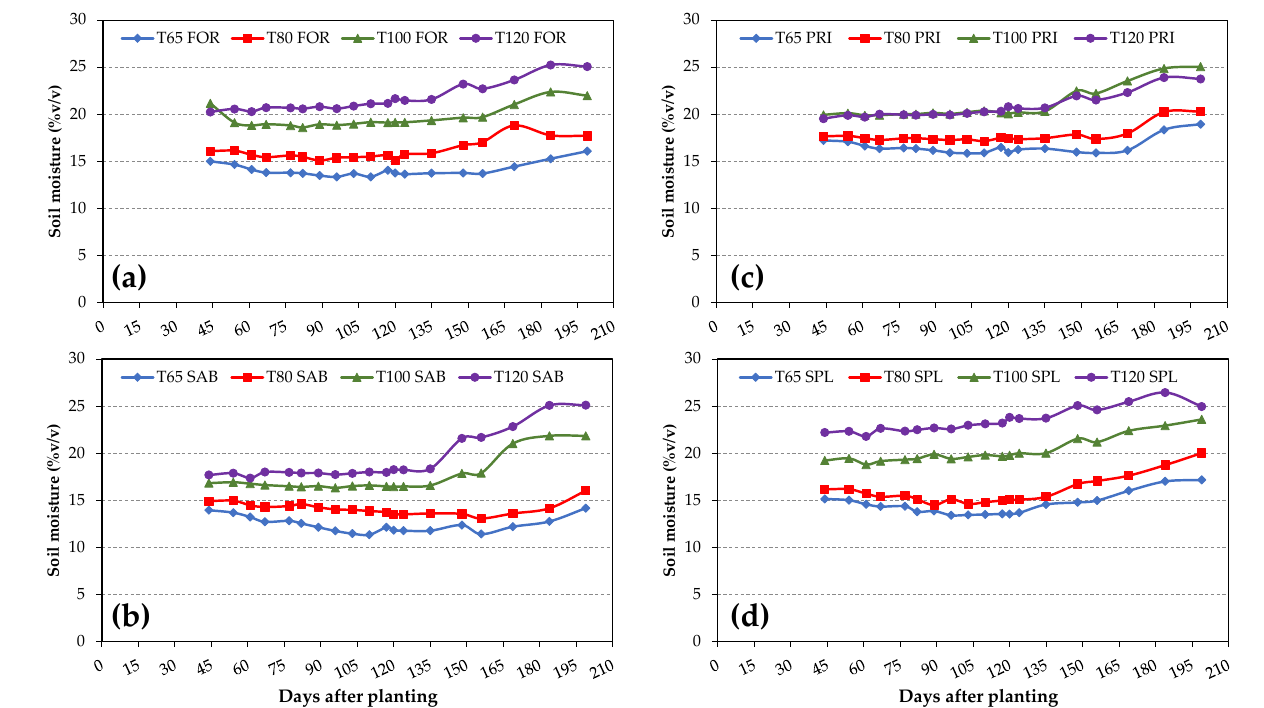
Figure 3. Soil water content measurements taken by the frequency domain reflectometry (FDR) probe in the top 80 cm of the soil on the T65, T80, T100 and T120 water treatments throughout the 2016–2017 cropping season in ( a ) ‘Fortuna’, ( b ) ‘Sabrina’, ( c ) ‘Primoris’ and ( d ) ‘Splendor’. Each data point represents the average of three separated profiles.